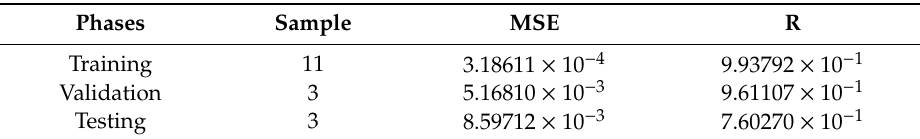
Table 4. Mean squared error and R values from model.